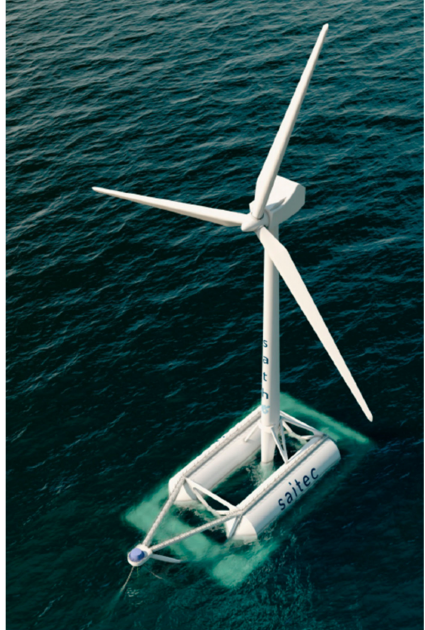
Figure 2. SATH ® platform concept. Source: Figure courtesy of Saitec